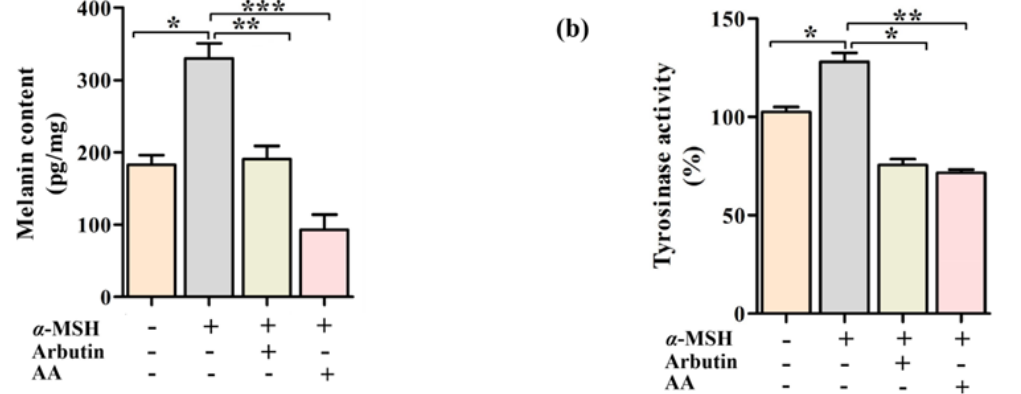
Figure 2. Effects of AA on cellular melanin synthesis and intracellular tyrosinase activity in α -MSH- induced PIG1 cells. Cells were treated with the indicated concentrations of AA for 24 h. The relative melanin content ( a ). The tyrosinase activity ( b ). Data are expressed as the mean ± SEM. * p < 0.05, ** p < 0.01 and *** p < 0.001 ( n = 3 per group).